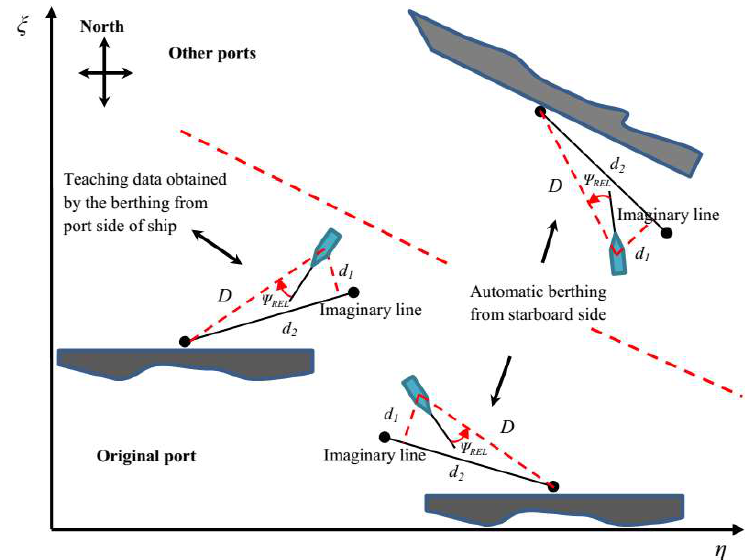
Figure 4. Automatic ship berthing for the berth-approaching on each side.